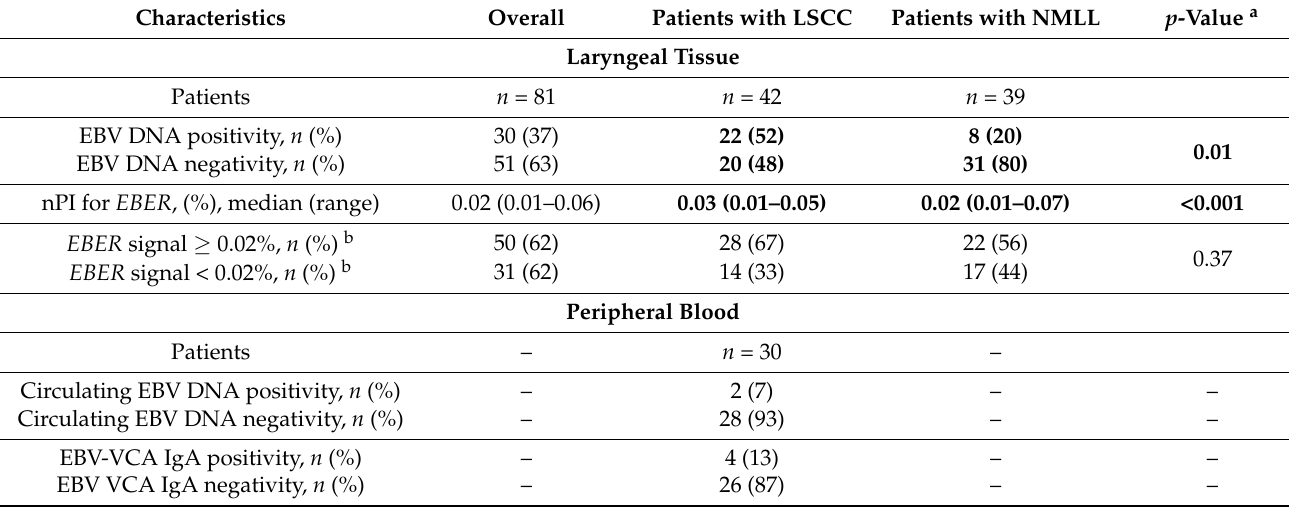
Table 2. EBV status in laryngeal tissue and peripheral